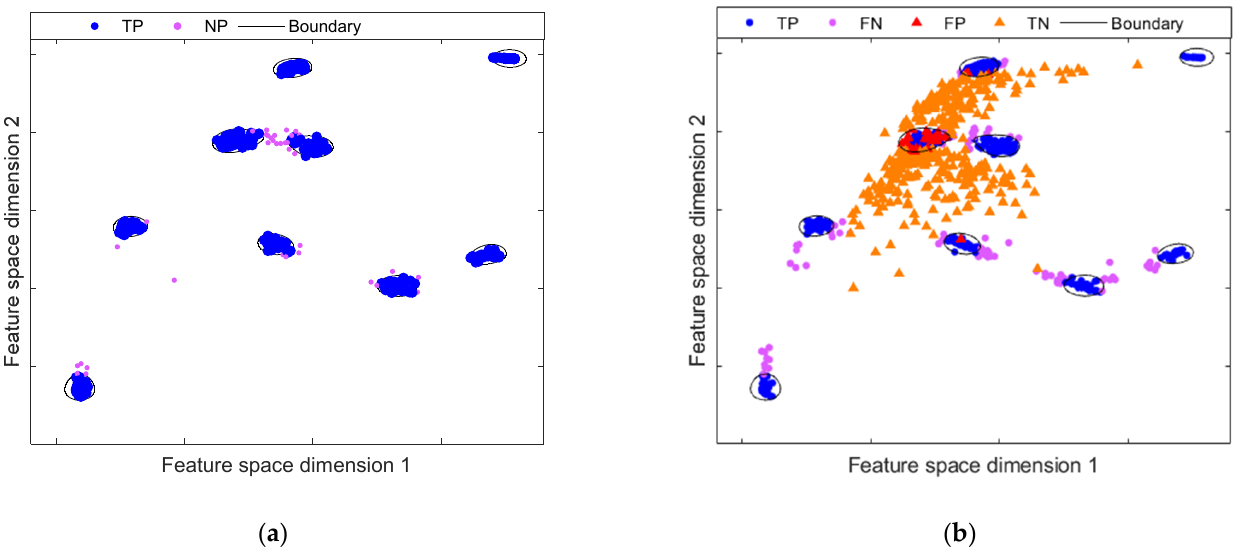
Figure 8. Anomaly detection model on compact feature space mapping resulting from DCC model by means OC-SVM: ( a ) initial anomaly model representation with compact features; ( b ) evaluation of the fault scenario F2; the compact representation of the normal class leads to a higher separation between the anomaly class, which results in a greater number of correctly classified samples, compared to traditional DAE.